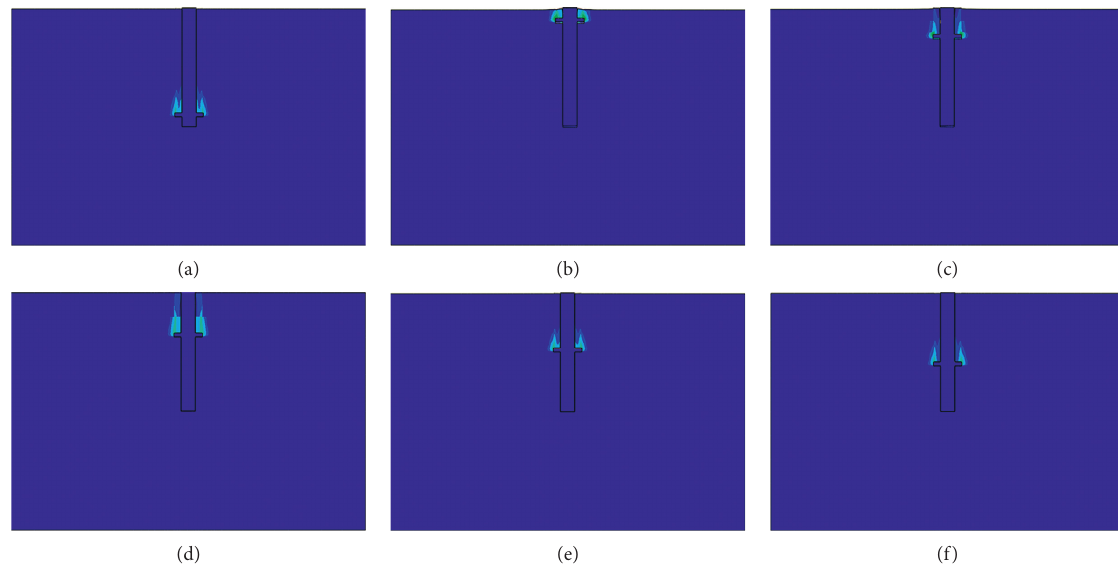
Figure 10: Plastic zone distribution of one root layer RP under ultimate bearing capacity. (a) RP No. 4. (b) RP No. 6. (c) RP No. 7. (d) RP No. 8. (e) RP No. 9. (f) RP No. 10.